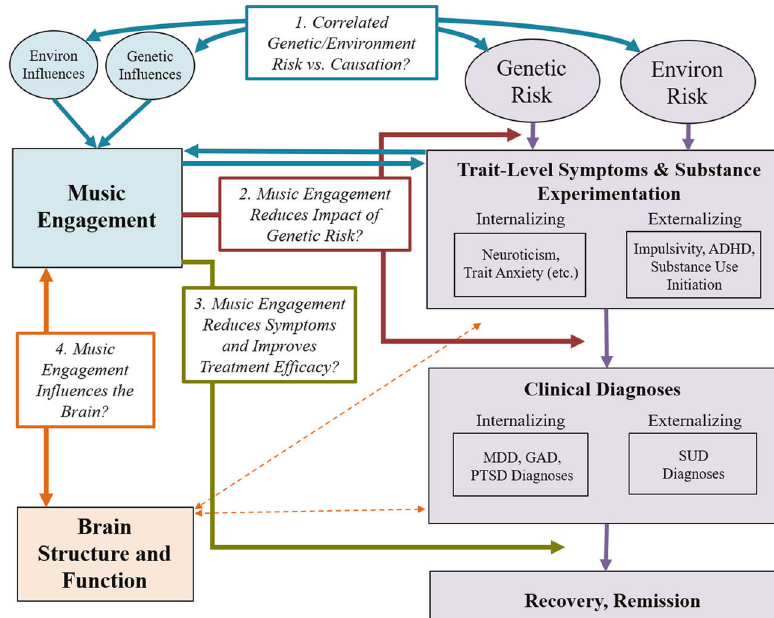
Fig. 2 Theoretical model. Progression of mental health problems is based on a diathesis-stress model, where genetic predispositions and environmental exposures result in later problems (which can be remedied through treatment). Potential associations with music engagement include (Path 1; blue arrows) correlated genetic/environmental in fl uences and/or causal associations between music engagement and trait- level mental health outcomes; (Path 2; red arrows) interactions between music engagement and risk factors to predict later trait-level or clinical level symptoms; and (Path 3; gold arrow) direct effects of music engagement on reducing symptoms or improving treatment ef fi cacy. Path 4 (orange arrows) illustrates the importance of understanding how these potential protective associations are driven by neuroanatomy and function. MDD major depressive disorder, GAD generalized anxiety disorder, PTSD posttraumatic stress disorder, SUD substance use disorder(s).